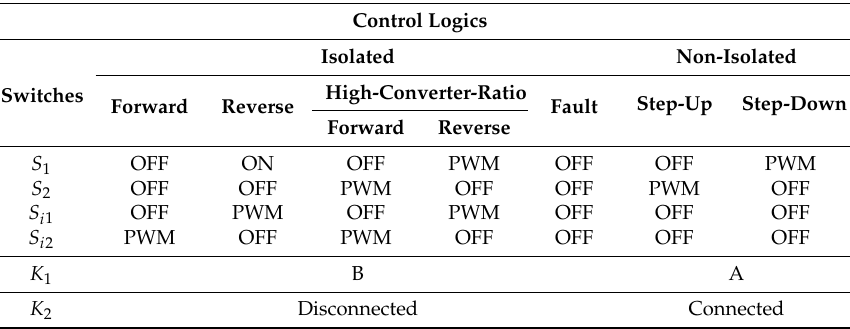
Table 1. The control logics of switches states.